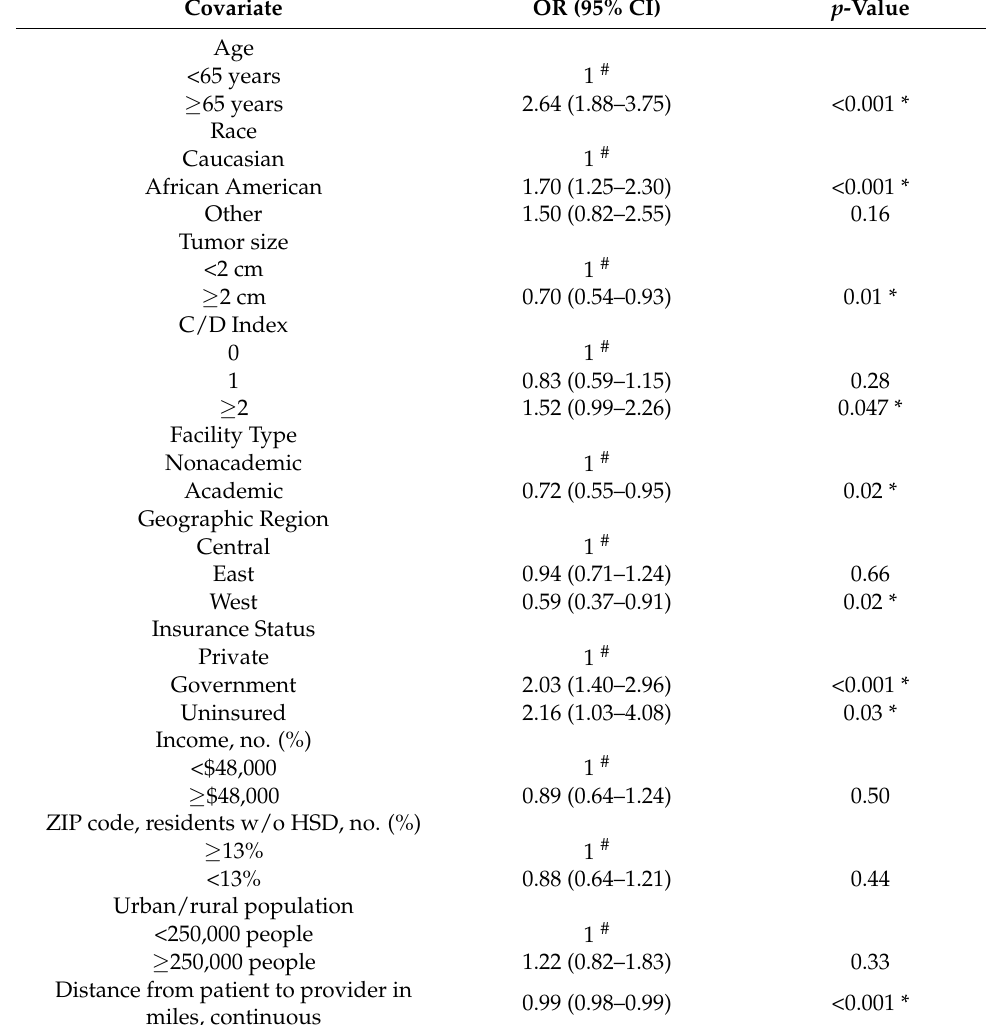
Table 2. Multivariate logistic regression analysis of clinical and sociodemographic factors predictive of surgery refusal ( n = 280) versus surgery receipt ( n = 33,946) for pituitary adenoma. Covariate OR (95% CI) p -Value Age <65